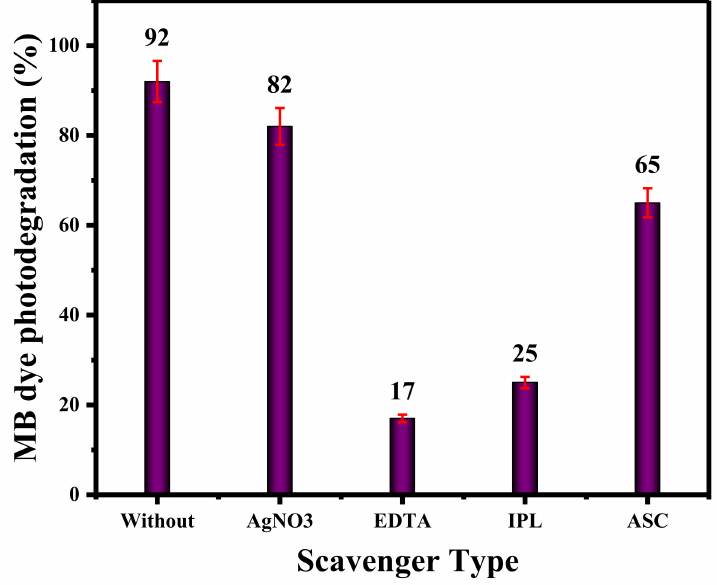
Figure 12. Quenching experiments of the proposed